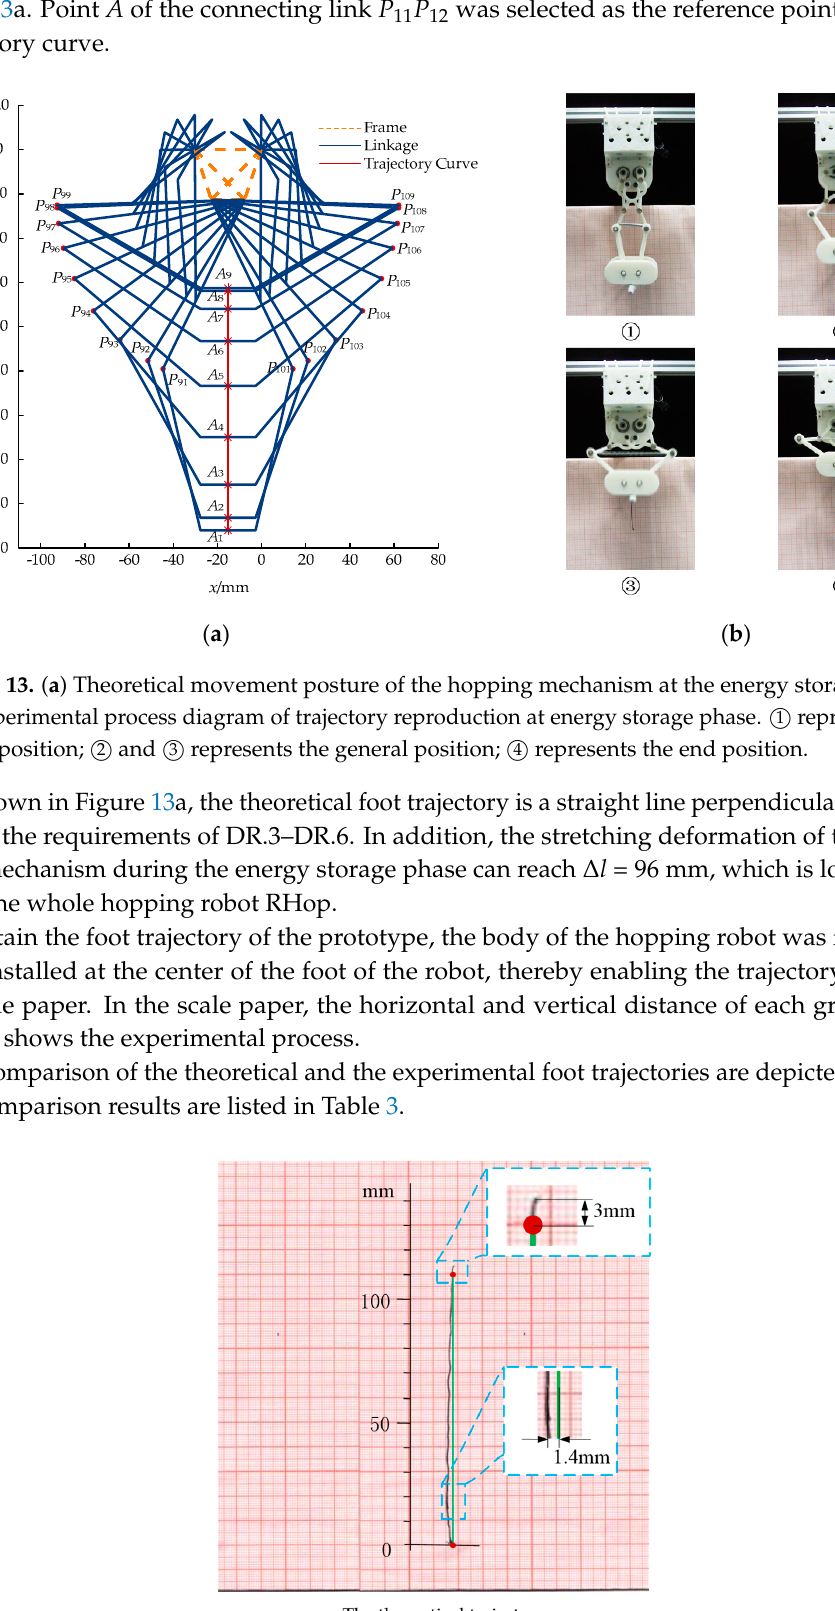
( b ) Figure 12. Robotic prototype. ( a ) Front view. ( b ) Side view. 4.2. Hopping Performance Analysis 4.2.1. Foot Trajectory Verification By substituting the optimization results of the hopping mechanism into Equations (5) and (6), the movement posture of the hopping mechanism in the energy storage phase can be obtained, as shown in Figure 13a. Point A of the connecting link P 11 P 12 was selected as the reference point to obtain the foot trajectory curve.